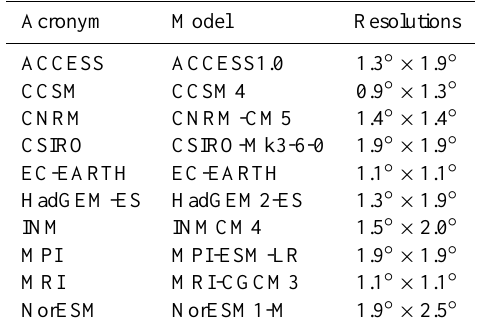
Table 1. List of models from the CMIP5 data set used in this study. Acronym